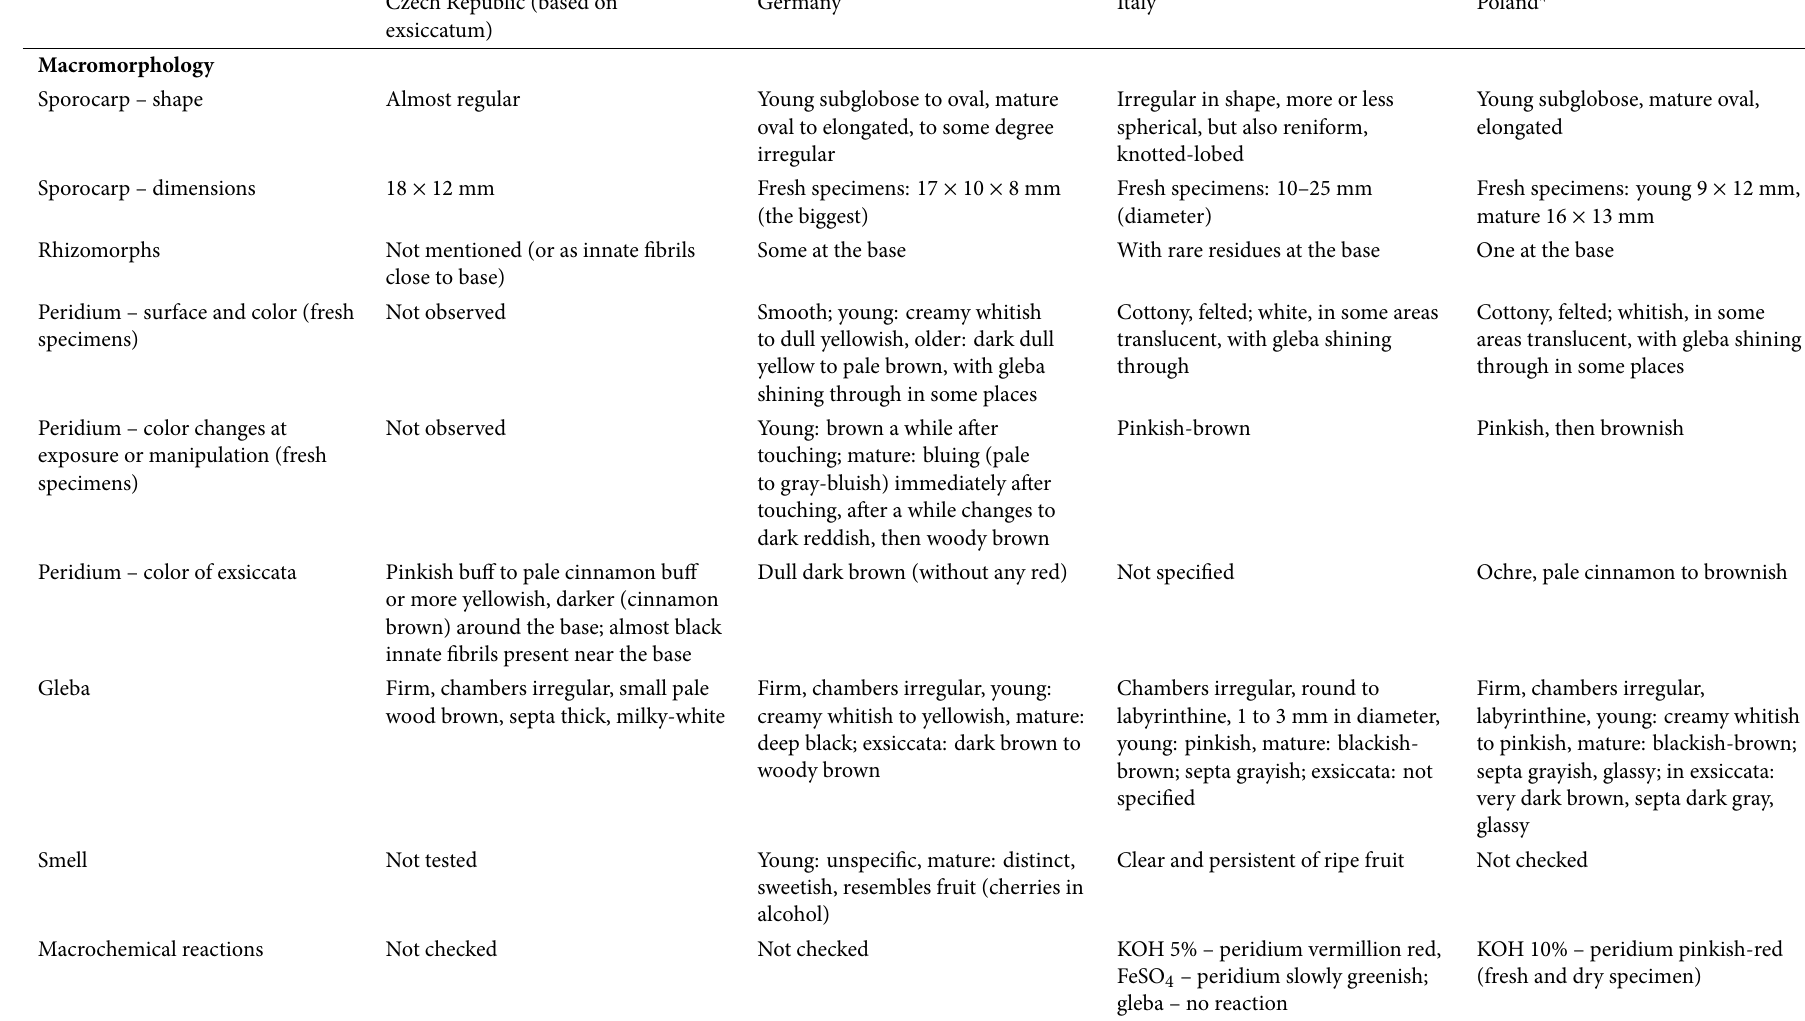
Table 1 A synoptic table of macro- and microcharacters and chemical reactions of Rhizopogon melanogastroides according to descriptions of specimens from the Czech Republic (Lange, 1957), Germany (Martín, 1996; Martín & Raidl, 2002), Italy (Bincoletto, 2014), and Poland (the present